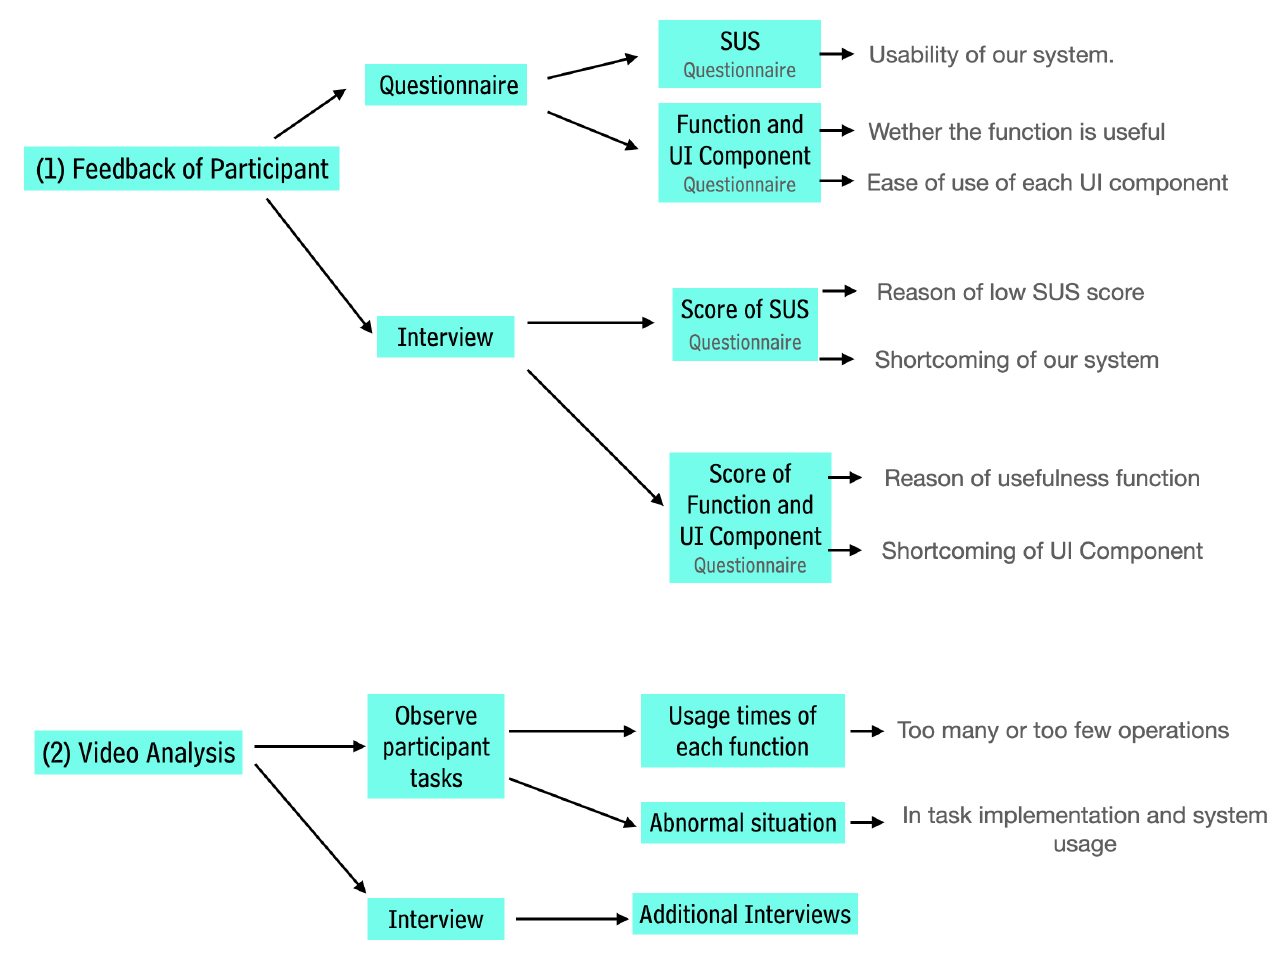
Figure 17. Software Prototype Evaluation